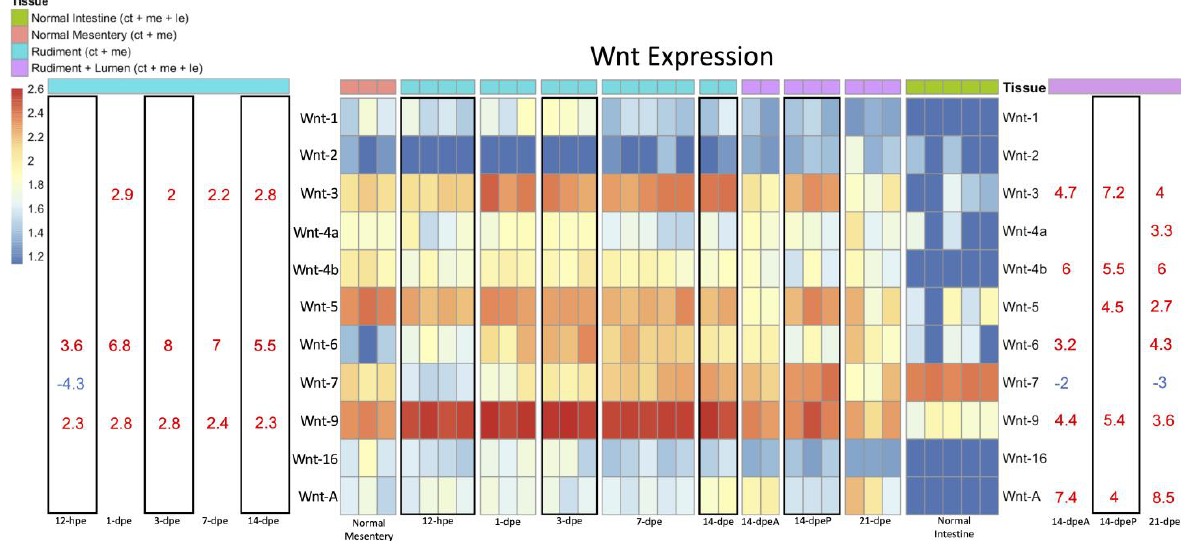
Figure 5. Heatmap of Wnt expression during early- and late-stage regeneration. This heatmap contains all the RNA-seq timepoints collected from our transcriptomic databases. The timepoints 12-hpe through 14-dpe should be referenced to Normal Mesentery, as this was the control. Similarly, the timepoints 14-dpeA, 14-dpeP, and 21-dpe should be referenced to Normal Intestine. On either side of the heatmap are the Log2foldchange (L2FC) values of a Wnt gene at a given timepoint. A significance threshold was set at L2FC <-2 or >2 with a pADJ value of 0.001. Above the columns are color coded labels that represent the tissue composition of the samples at a given timepoint. Abbreviations — CT: connective tissue, ME: mesothelium, and LE: luminal